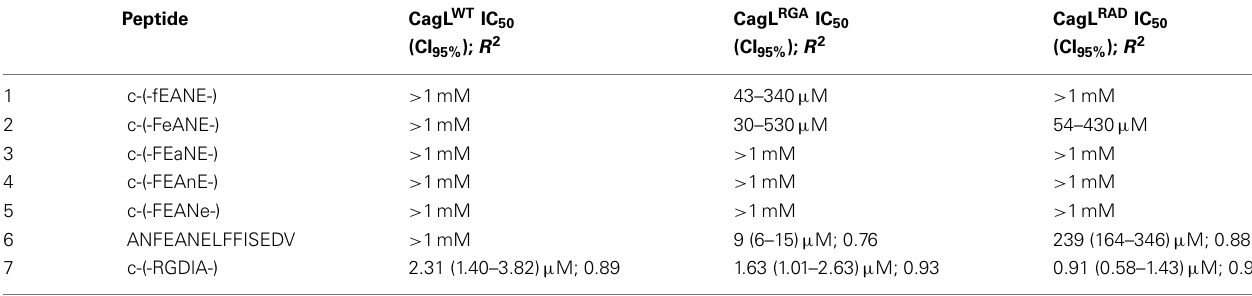
Table 3 | Inhibition ofWM-115 cell adhesion to CagL by synthetic peptides a .